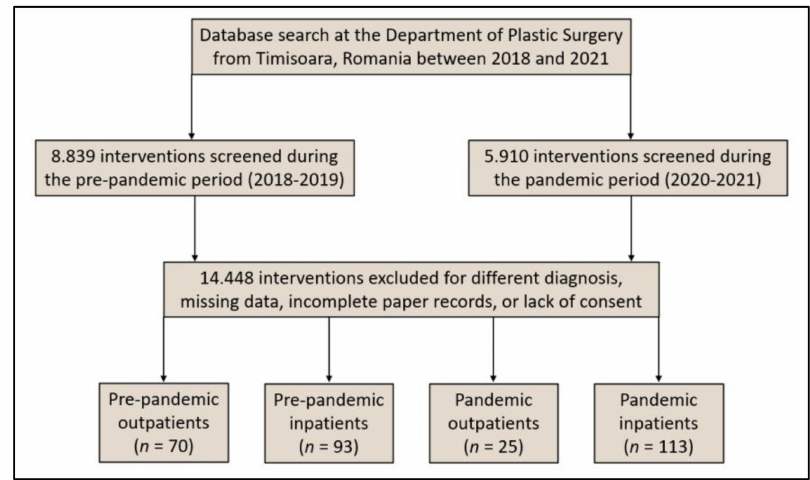
Figure 1. Flowchart displaying the inclusion process of patients with malignant melanoma during the 4-year study period.